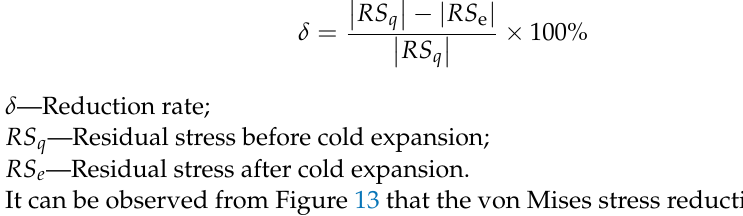
Figure 13. Von Mises stress reduction rate in the center thickness of the forging. The stress reduction rate could be expressed by Equation